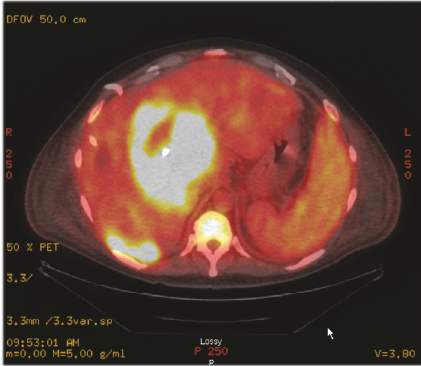
Figure 2: Postbiopsy PET/CT